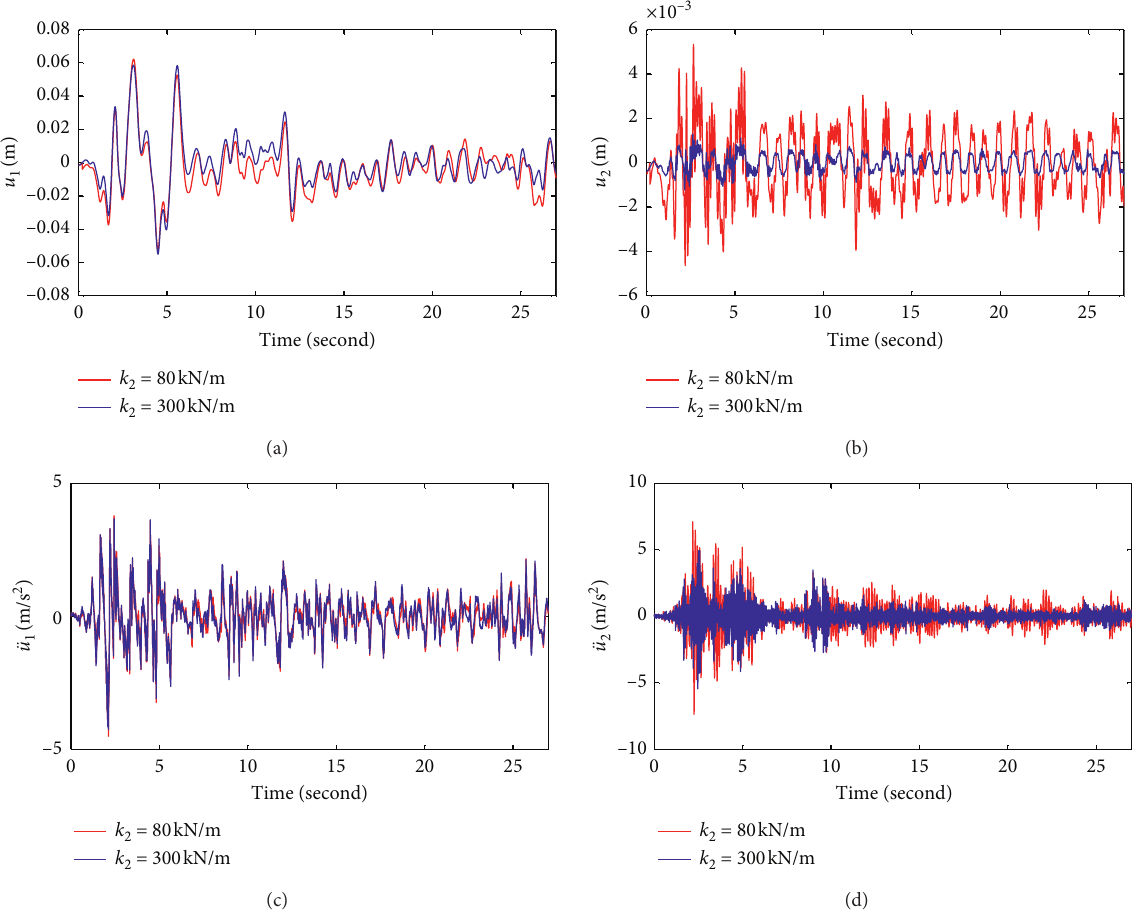
Figure 12: Comparison of the dynamic responses of the main beam and the pier for the minimum and maximum values of k � 80kN/m. Maximum: k � 300kN/m. (a) Displacement of the main beam, (b) displacement of the pier, (c) ac- μ � 0.05. Minimum: k 2 2 celeration of the main beam, and (d) acceleration of the